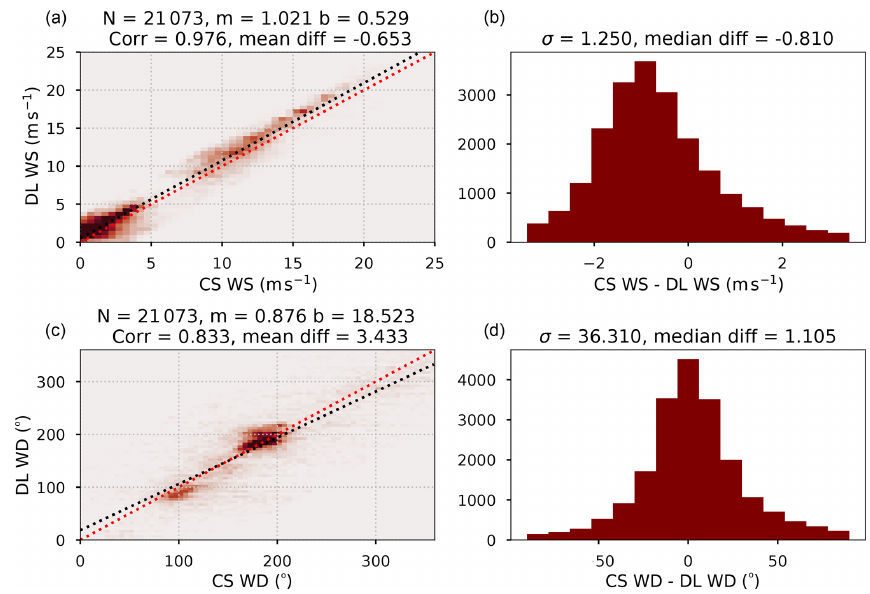
Figure 4. Two-dimensional histograms of DL-measured wind speed vs. CopterSonde-measured wind speed (a) and DL-measured wind direction vs. CopterSonde-measured wind direction (c) . The 2D histograms are binned to 0.5ms − 1 for wind speed and 5 ◦ for wind direction. The histograms on the right show the difference in wind speed (b) and wind direction (d) . The dotted red line is the one-to-one line and the black line is the least-squares regression. The slope (m) and intercept ( b ) are shown in the title. Various other statistics are also shown in the titles. N corresponds to the number of points, Corr is the Pearson correlation, mean diff is the mean difference between the CopterSonde and the DL, σ is the standard deviation of the differences, and median diff is the median difference between the CopterSonde and the DL.